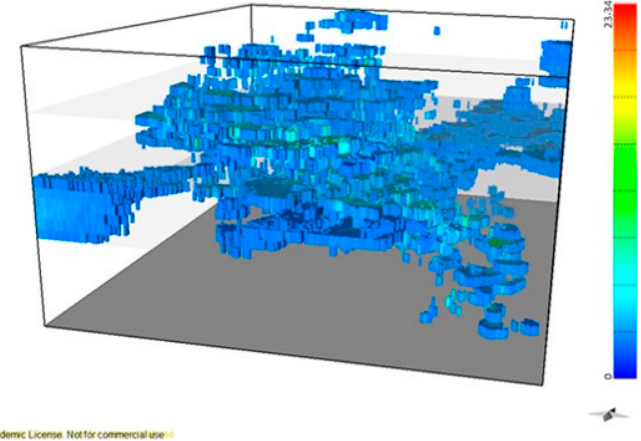
Figure 18. 3D view of the average wolframite potential in tons. The representation is made using the final grid resolution of 10 m × 10 m × 10 m.